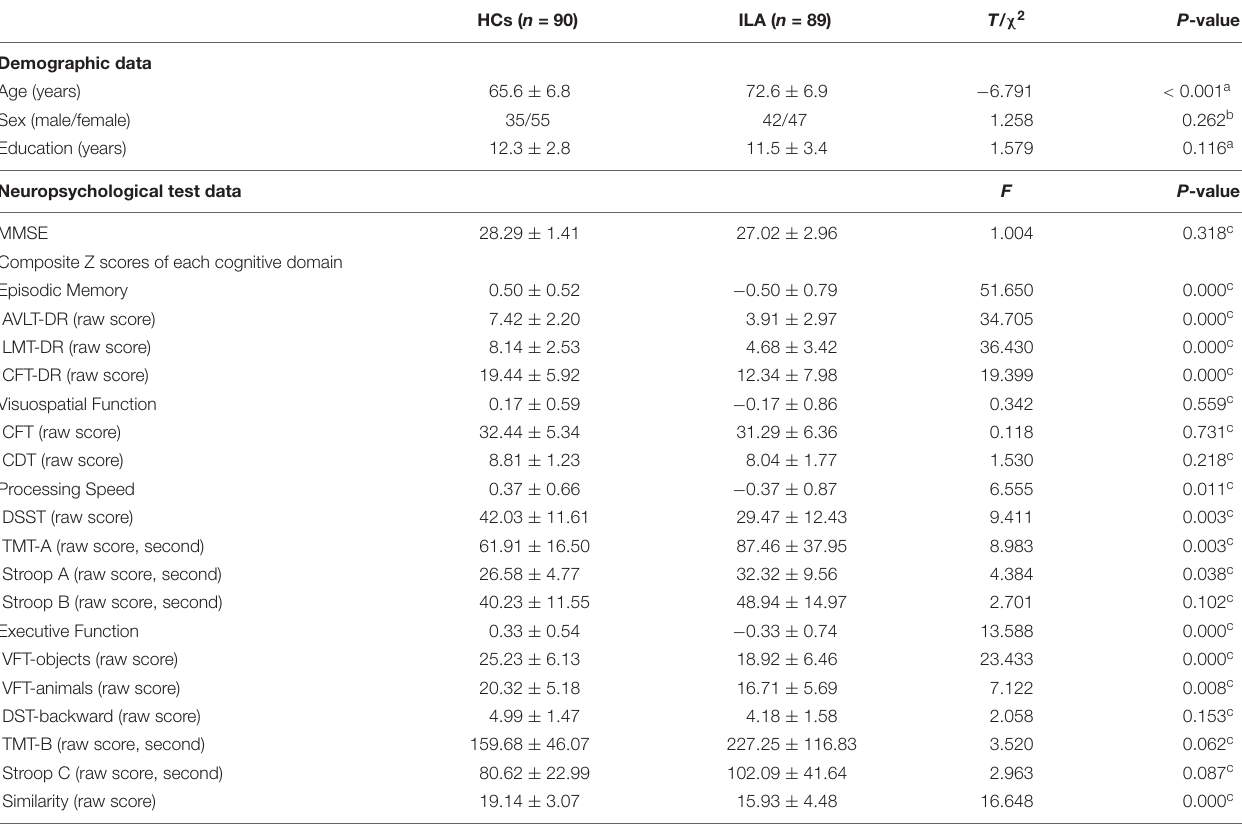
TABLE 1 | Demographic and neuropsychological data for ILA and control groups.